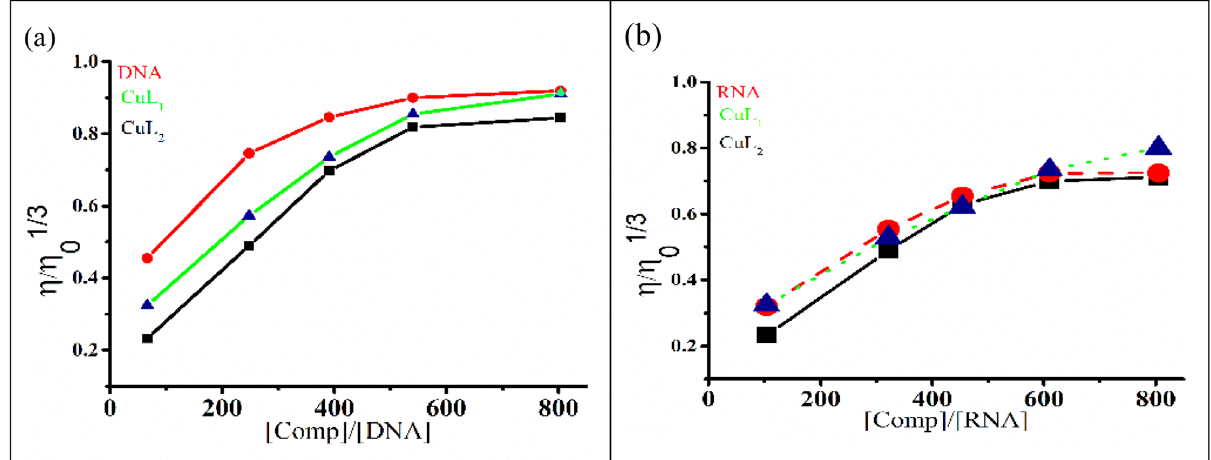
Figure 6: E ff ect of the Cu ( II ) complexes ([ Cu ( L 1 ) 2 ] ( 1 ) and [ Cu ( L 2 ) 2 ] ( 2 )) on the relative viscosities of ( a ) ct - DNA and ( b ) tRNA at